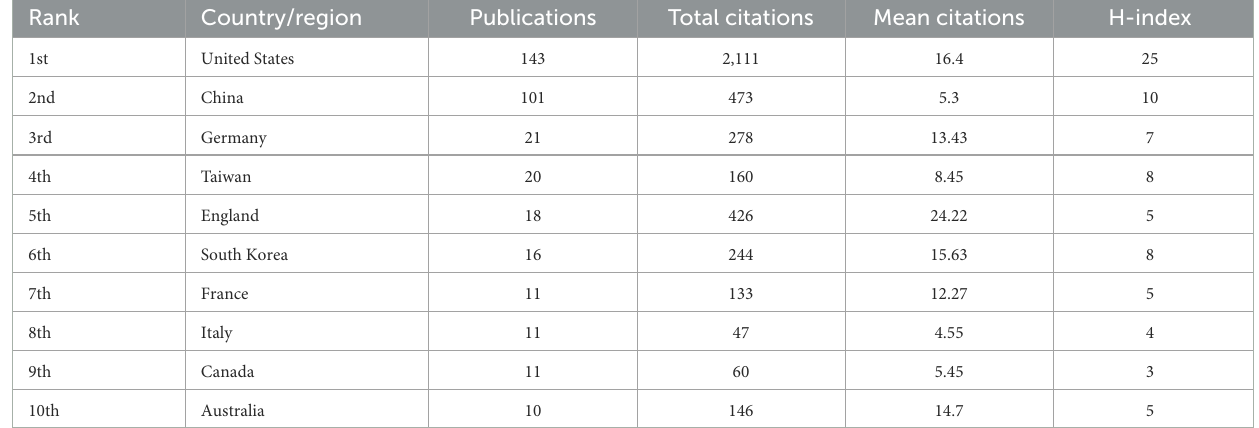
TABLE 1 Top 10 countries by publications, H-index, and